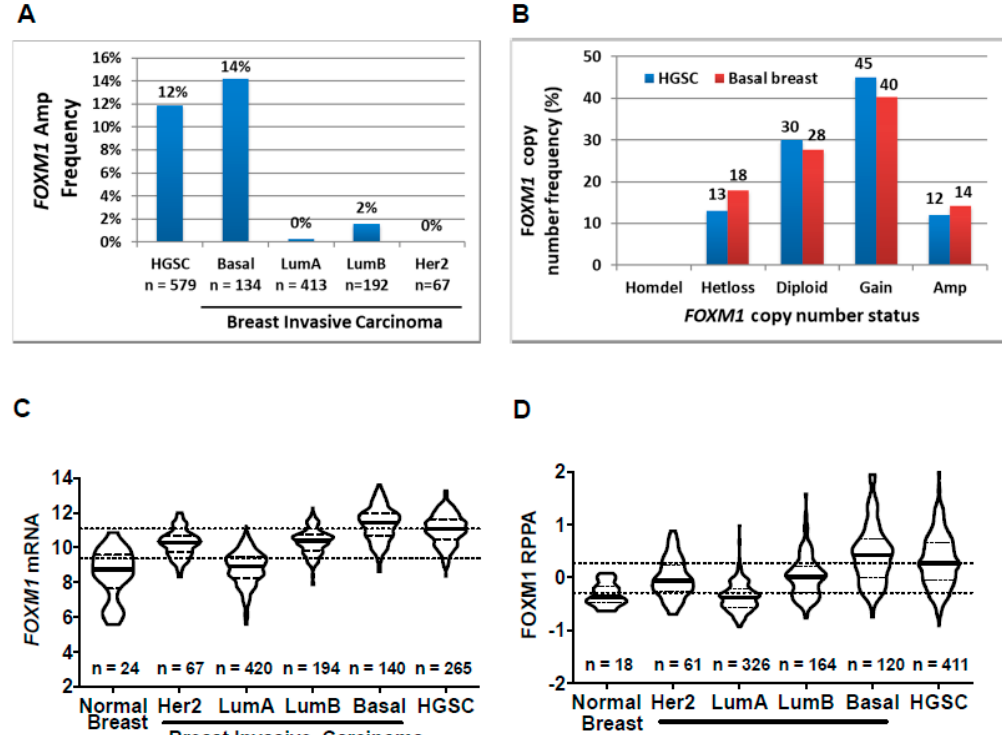
Figure 5. FOXM1 copy number alterations (CNA) and expression in TCGA OV (HGSC) vs. BRCA (Breast) molecular (PAM50) subtypes. ( A ) FOXM1 amplification frequency in HGSC vs. breast molecular subtypes. ( B ) FOXM1 copy number status in HGSC vs. basal breast. ( C,D ) FOXM1